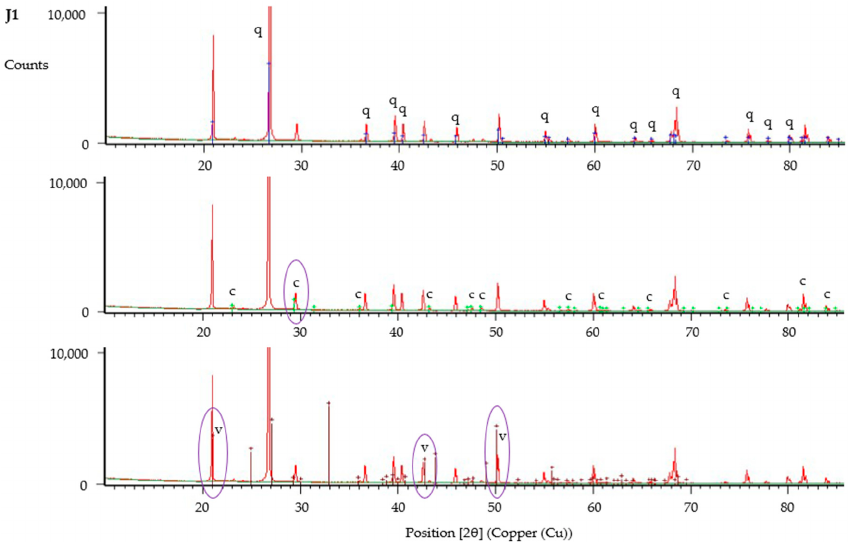
Figure 16. X-ray powder diffraction (XRD) analysis of sample from column J1, showing identified peaks of quartz (q), calcite (c) and vaterite (v).